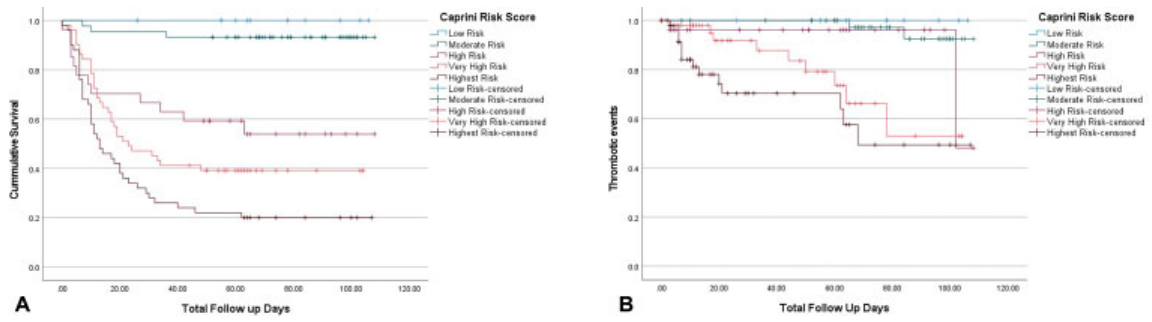
Fig. 4 ( A ) Kaplan – Meier curve demonstrating survival of different groups by Caprini score. ( B ) Kaplan – Meier curve demonstrating cumulative thrombotic event survival of different groups by Caprini